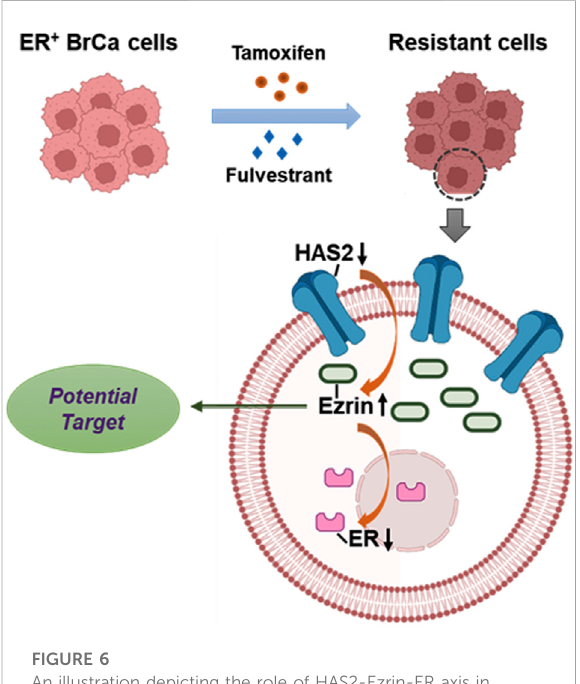
FIGURE 6 An illustration depicting the role of HAS2-Ezrin-ER axis in endocrine resistance of ER +